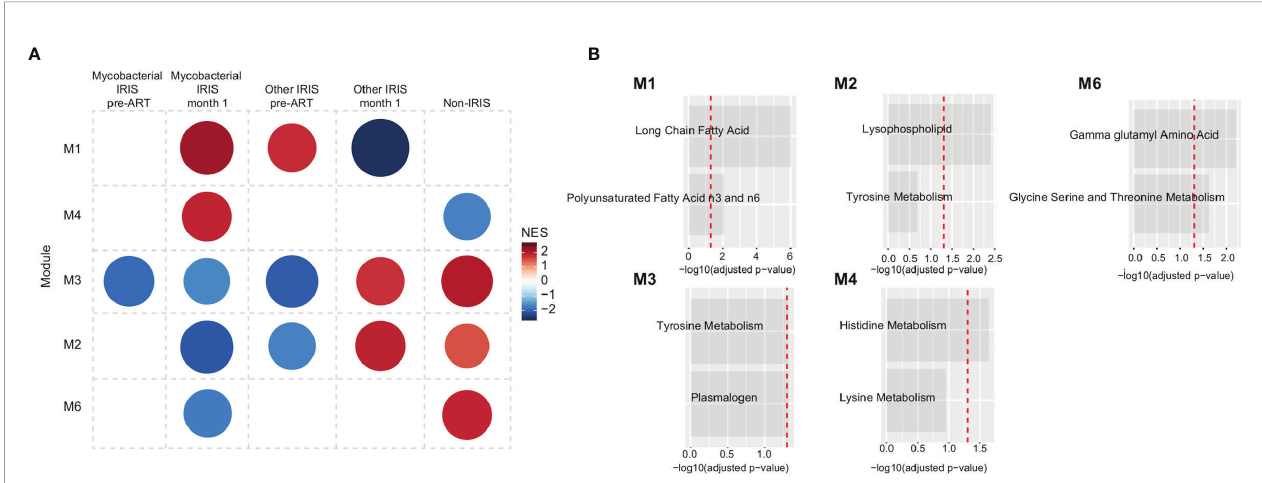
FIGURE 6 | Metabolic pathway module analysis for different types of IRIS. (A) Co-expressed pathway modules are obtained by CEMiTool R package using the measured metabolite levels of mycobacterial IRIS, other types of IRIS, and non-IRIS groups at the pre-ART and month 1 time points. Module representation is re fl ected by the network enrichment scores (NES) (B) Annotated metabolic pathways that de fi ne each statistically signi fi cant module are